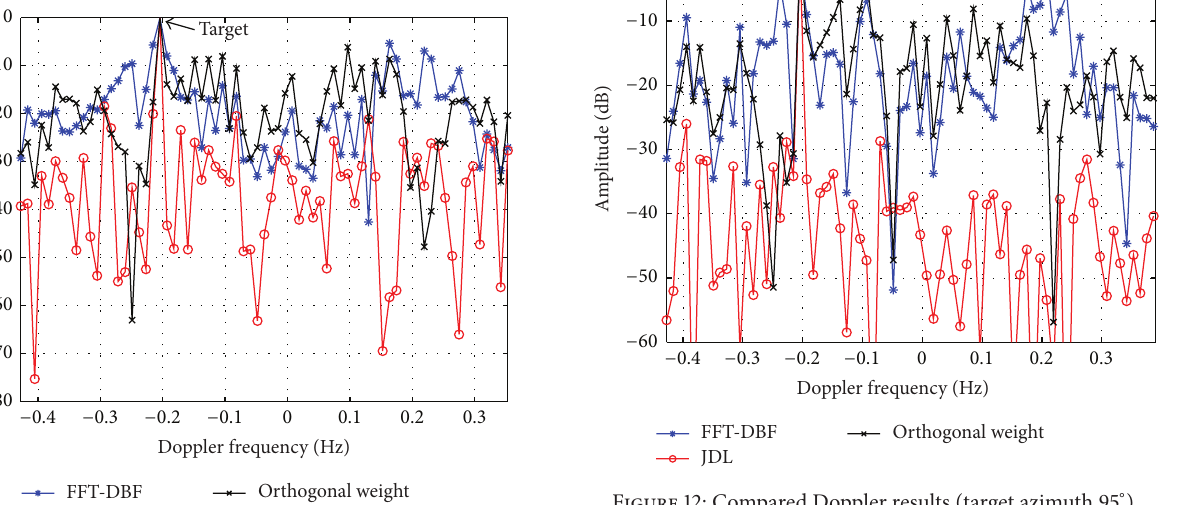
Figure 12: Compared Doppler results (target azimuth 95 ∘